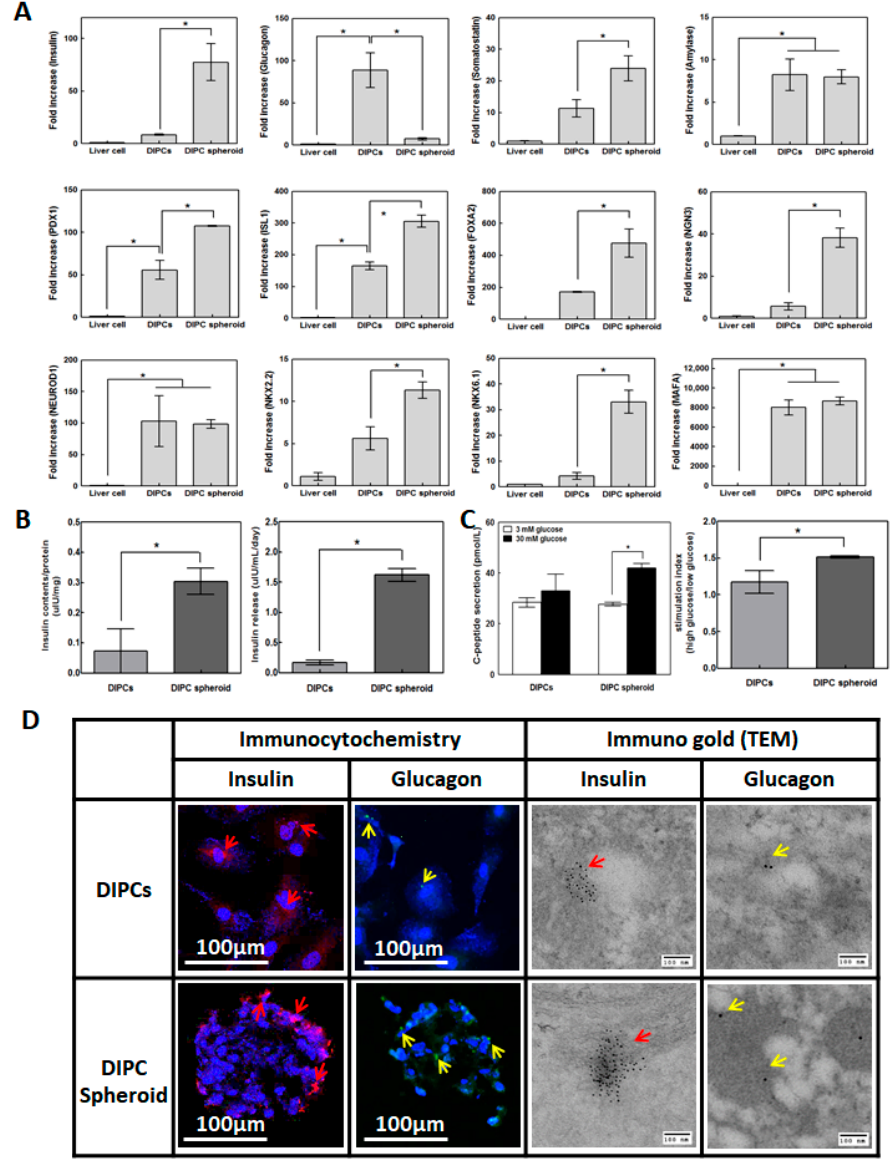
Figure 2. Trans-differentiation efficacy of DIPCs and DIPC spheroids. ( A ) The gene expression of insulin, glucagon, somatostatin, amylase, and pancreas-specific transcription factors ( n = 4). ( B ) Insulin contents of and release from DIPCs and spheroids ( n = 4). Spheroids showed higher insulin production than DIPCs. * indicates a significant difference between two groups ( p < 0.05). ( C ) The glucose-stimulated insulin secretion index was calculated by dividing the c-peptide concentration of the supernatant of cells incubated with 30 mM glucose by that of cells incubated with 3 mM glucose ( n = 4). ( D ) Representative insulin and glucagon staining using immunocytochemistry and TEM in DIPCs and DIPC spheroids. Red: insulin; green: glucagon; blue: nuclei; Original magnifications: ×100. The red arrow indicates an insulin immunoGold aggregate (9–11 nm); the white arrow indicates a glucagon immunoGold aggregate dot (5 nm).